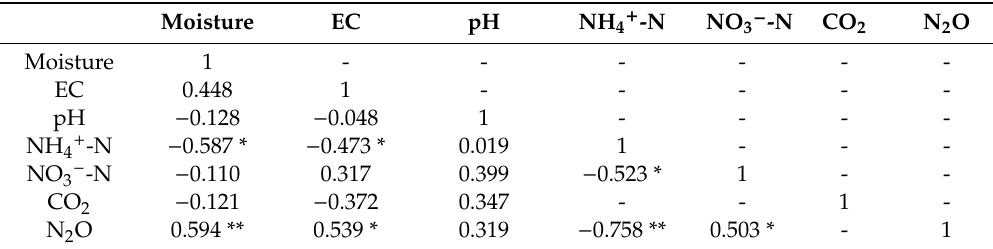
Table 1. Pearson correlation analyses between the mean gas emissions and the mean soil properties of the four main growth periods.